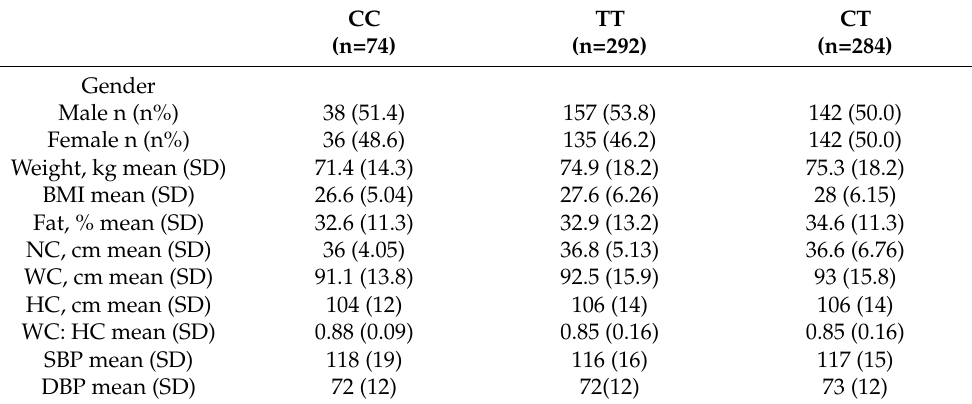
Table 1. Demographic, anthropometric and clinical characteristics of the studied population according to their genotype.